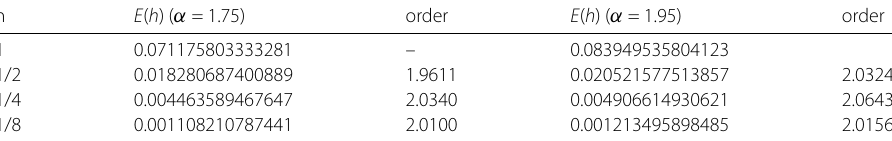
Table 1 The convergence order in spatial direction with α = 1.75,1.95, τ = 1/256 at time t = 1 h E ( h ) ( α = 1.75) order E ( h ) ( α =